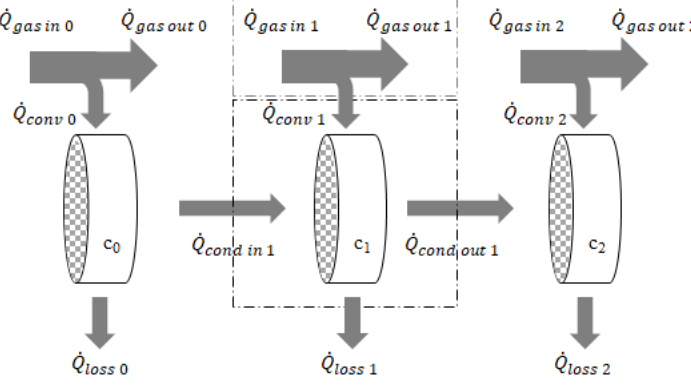
Figure 4. Schematic structure of the chosen simulation strategy.